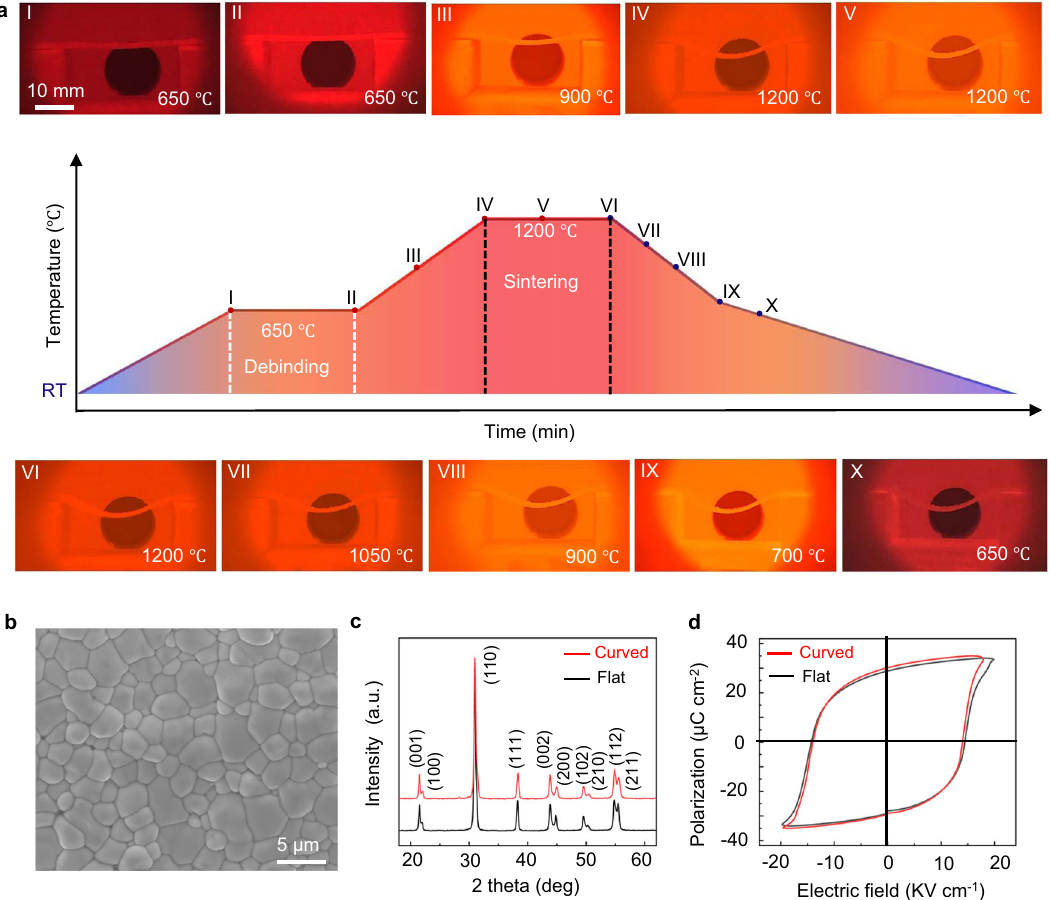
Fig. 2 Fabricating PZT ceramic via the gravity-driven sintering (GDS) technique. a Typical temperature pro fi le of the GDS process. The photograph I to X demonstrate the formation process of curved geometry, where the curved con fi guration forms during III to IV and it maintains from IV to the end. RT represents room temperature. b SEM image of the curved surface of the obtained PZT ceramic. c The XRD patterns of the obtained curved and fl at PZT ceramic. The two specimens exhibit an identical crystal structure (tetragonal phase). d Room temperature P - E hysteresis loops of the curved and the fl at PZT ceramic measured at 10 Hz, indicating that the GDS-sintered and conventional-sintered PZT ceramics possess similar ferroelectric